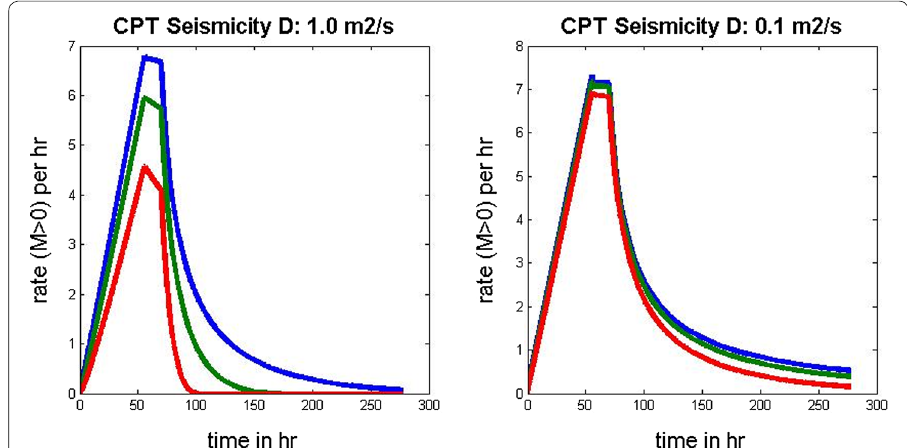
variable C CPT ( blue 1 kPa; green 5 kPa; red 20 kPa) for pressure dropping to zero at 70 h after start of injection. Left panel ( D 1.0 m 2 /s): lower C CPT is associated with a higher level of seismicity at constant injection rate = and larger decay times after shut-in. Right panel ( D